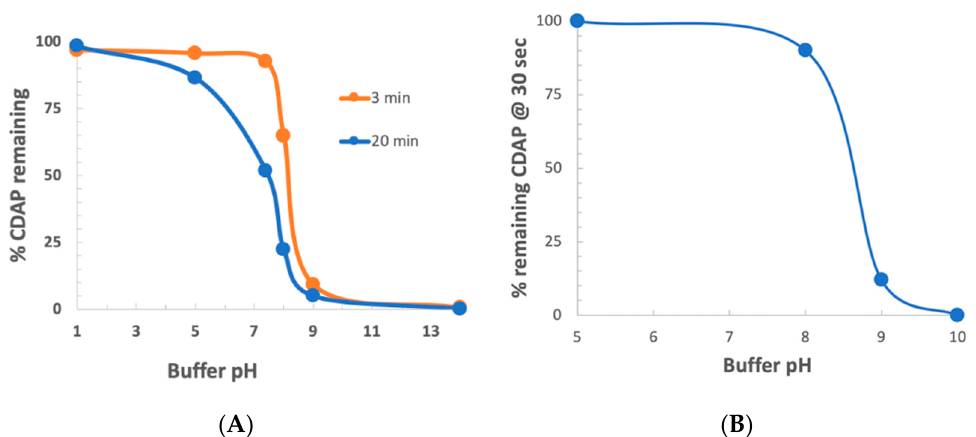
Figure 3. % CDAP remaining as a function of pH. ( A ) % CDAP remaining at 3 and 20 min as a function of pH at room temperature, assayed by absorbance at 312 nm. ( B ) % CDAP remaining at 30 s at room temperature, assayed by absorbance at 310 nm. 100% = CDAP transferred to 0.1 M HCl only. All buffers are 0.1 M: pH 1 (HCl), pH 5 (sodium acetate), pH 7 and 8 (sodium HEPES), pH 9 (sodium borate) and pH 10 (sodium carbonate).